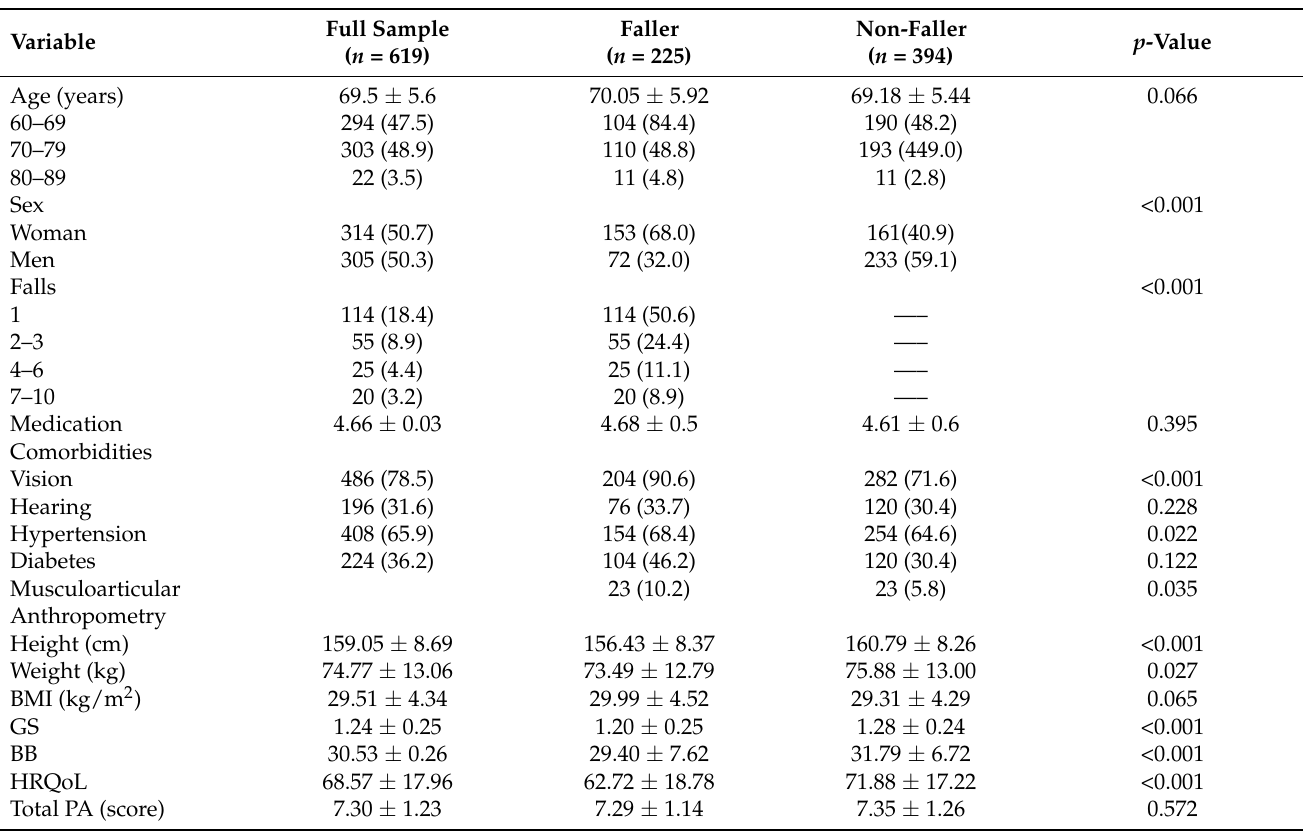
Table 1. Main characteristics of the